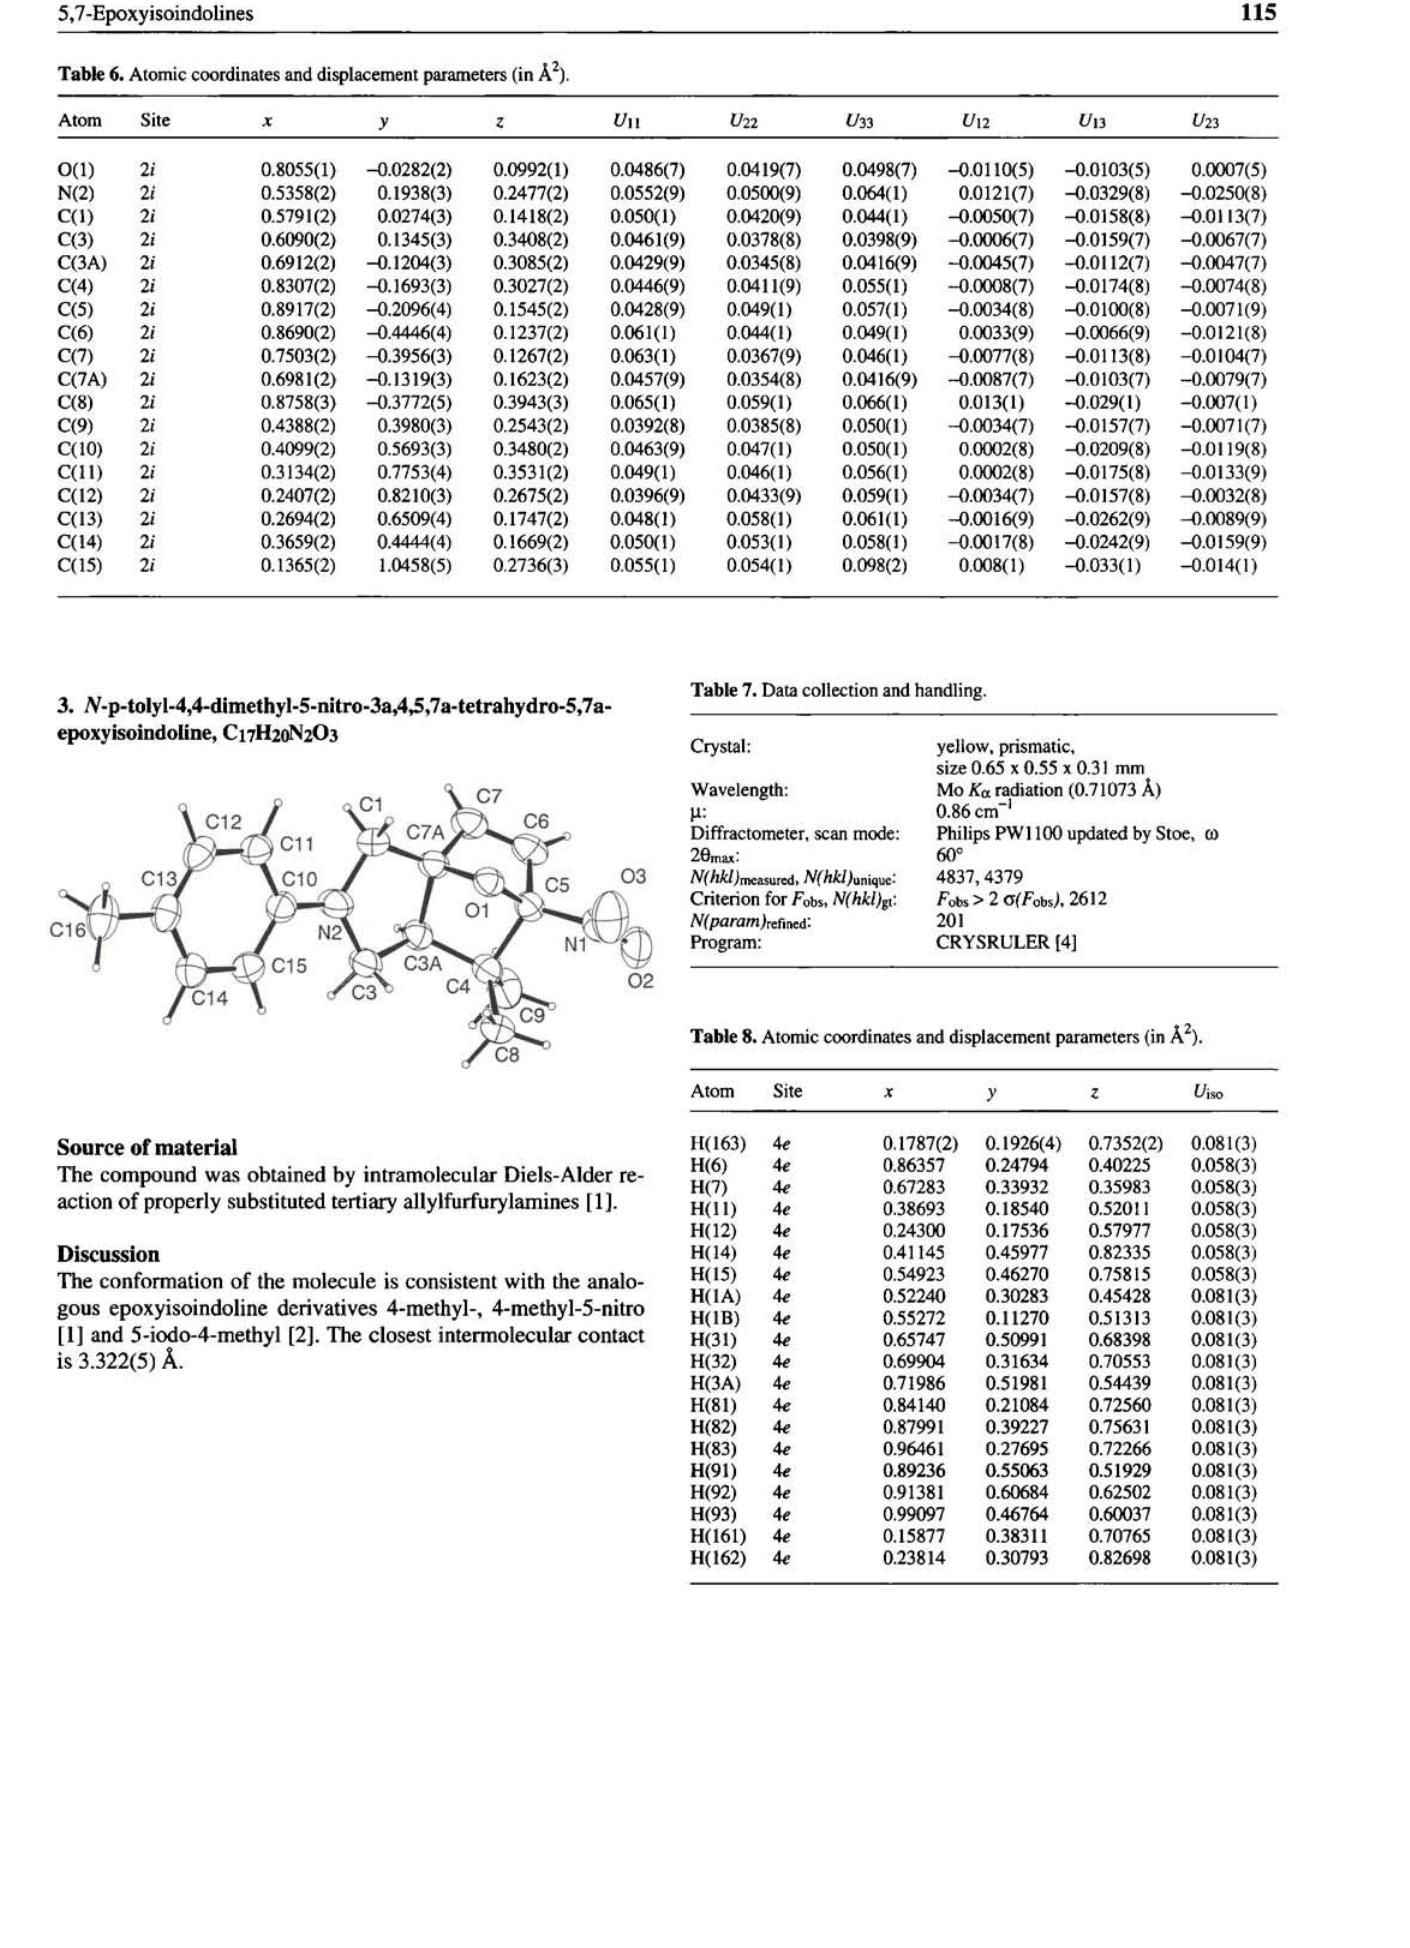
Table 6. Atomic coordinates and displacement parameters (in Â 2 ).